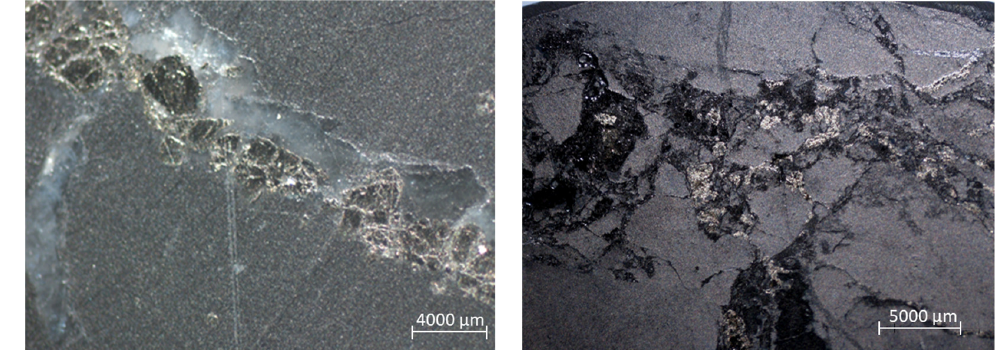
Figure 2. Sulfide dissemination in the samples of CGO ( left ) and DOS ( right ).